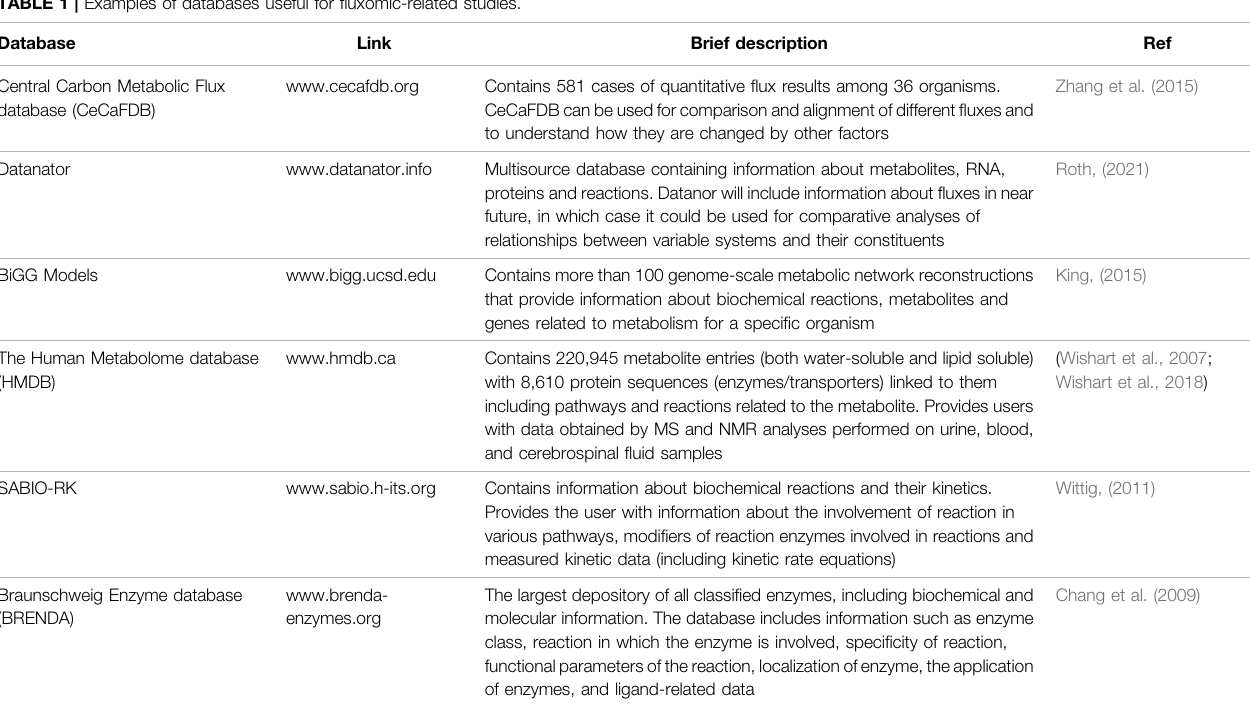
TABLE 1 | Examples of databases useful for fl uxomic-related